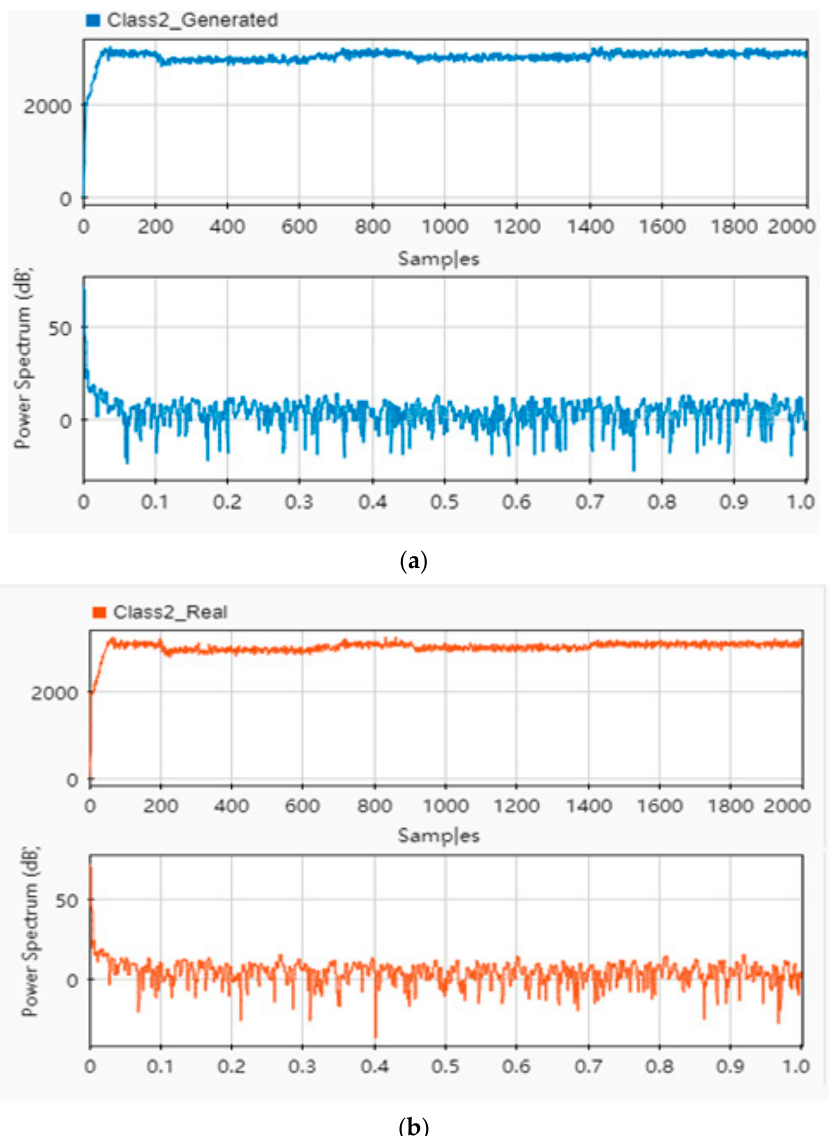
Figure 8. Comparison of generated actuator leak signal and original fault signal. ( a ) Generated sample signals. ( b ) Actual fault signals.